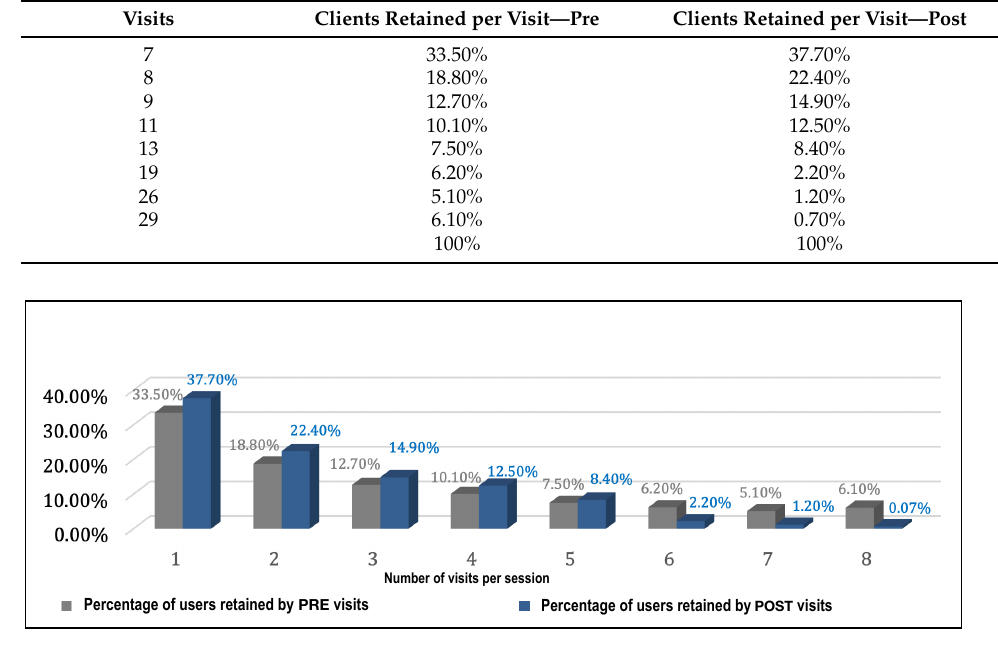
Figure 4. Comparison of clients retained by visits in the pre- and